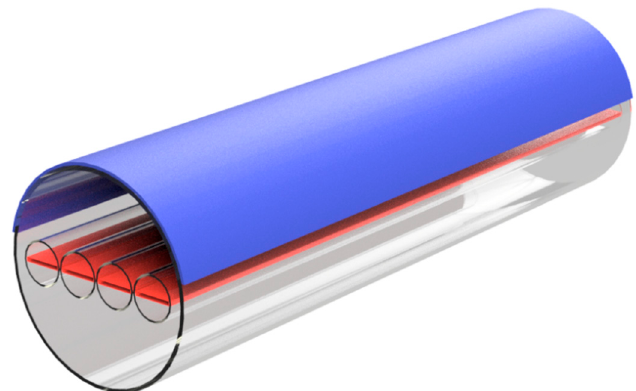
Figure 3. Rendering of the novel CPVT receiver with bendable PV cells, solid absorption filters and enveloping glass tube.